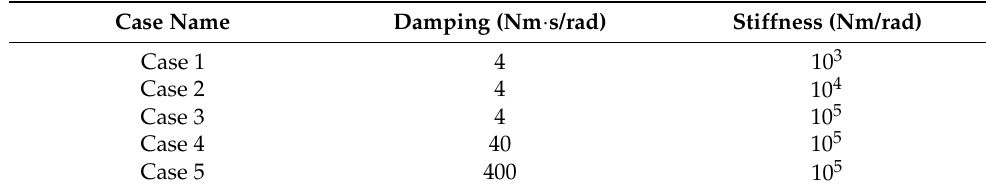
Table 7. Motor shaft damping and stiffness.